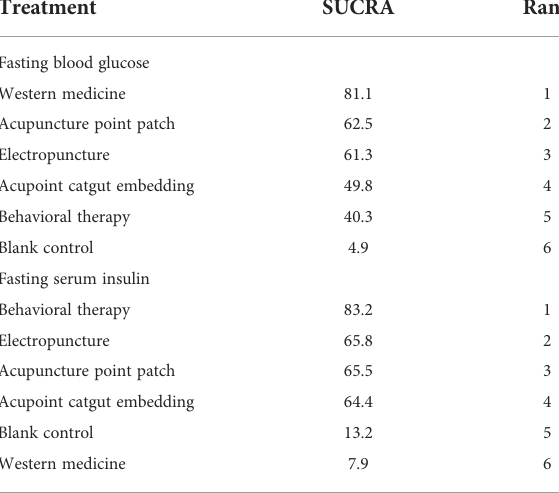
TABLE 1 Ef fi cacy ranking of mesh meta-analysis: fasting blood glucose and fasting serum insulin.